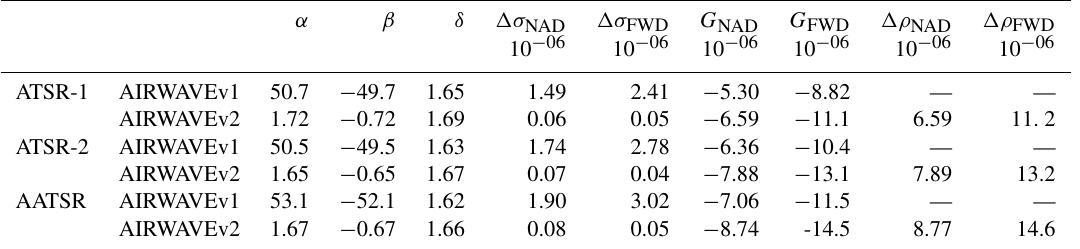
Table 1. AIRWAVE v1 and AIRWAVEv2 retrieval parameters for tropical summer atmosphere and along-track configuration (subsatellite view at 0 and 55 ◦ ). α β